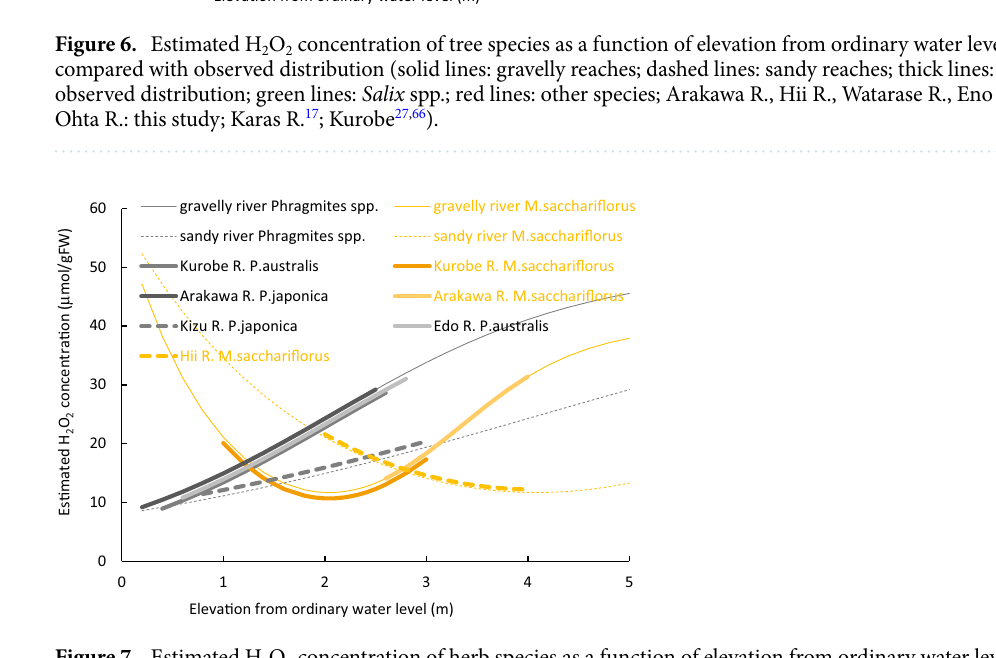
(elevation, soil moisture content, H 2 O 2 , TN, TP, and TN: TP). The H 2 O 2 concentration of tree species increased with higher soil moisture content, yet in terms of Salix spp., the relation is vise-versa. In the case of herb species, Phragmites spp. shows a significant negative correlation with soil moisture content and H 2 O 2 , whereas M. sac- chariflorus shows a “U” shaped correlation with soil moisture content and H 2 O 2 . Considering these situations and derived equations, tree and herb species were divided into four groups in GAM analysis. Twso groups from tree species ( Salix spp. and other tree species), and another two groups from herb species ( Phragmites spp. and M. sacchariflorus ). Salix spp., Phragmites spp., M. sacchariflorus , exhibit significant correlation with soil moisture content and H 2 O 2 among parameters (elevation, soil moisture content, H 2 O 2 , TN, TP, and TN: TP) (Tables 1, 2 and 3). In the case of other tree species, significant correlation occurs with H 2 O 2 and soil moisture content